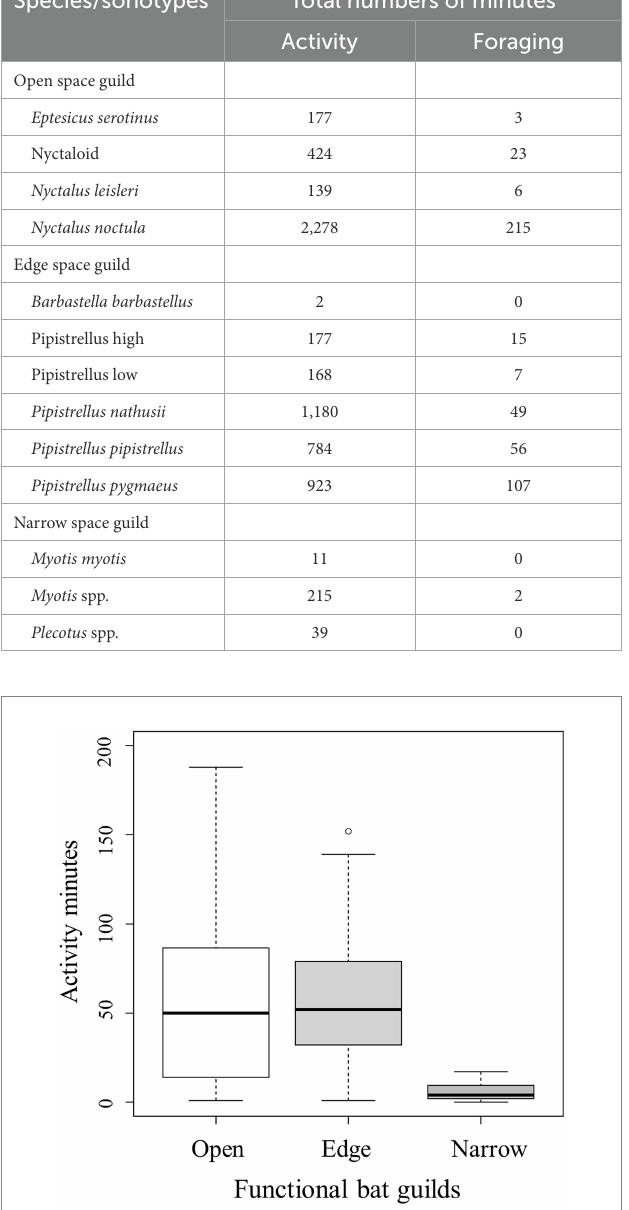
FIGURE 2 Nightly activity minutes of bat guilds (open, edge, and narrow space) counted during 47 nights on 12 dry grassland